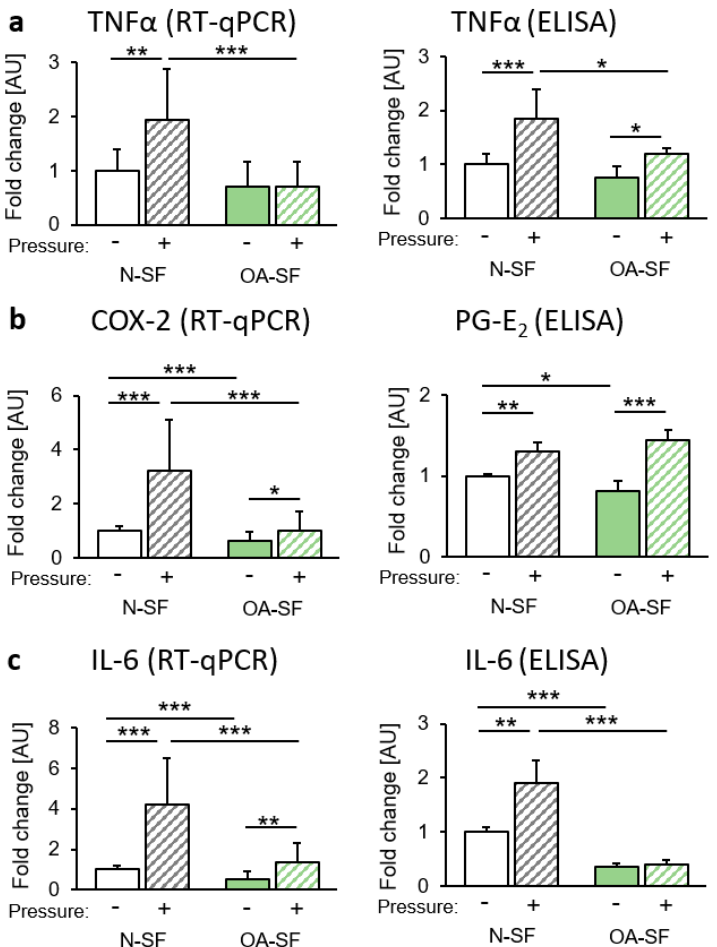
Figure 1. Impact of static compressive force application on the expression of proinflammatory genes. Gene expression and protein secretion of ( a ) TNF- α , ( b ) COX-2/PG-E2 and ( c ) IL-6 of N-SF and OA-SF after 48 h with or without static compressive force application. AU: arbitrary units; RT-qPCR: n = 9; ELISA: n = 6. * p ≤ 0.05, ** p ≤ 0.01, *** p ≤ 0.001. Statistics: Welch-corrected ANOVA with Games-Howell post ‐ hoc ‐ tests.